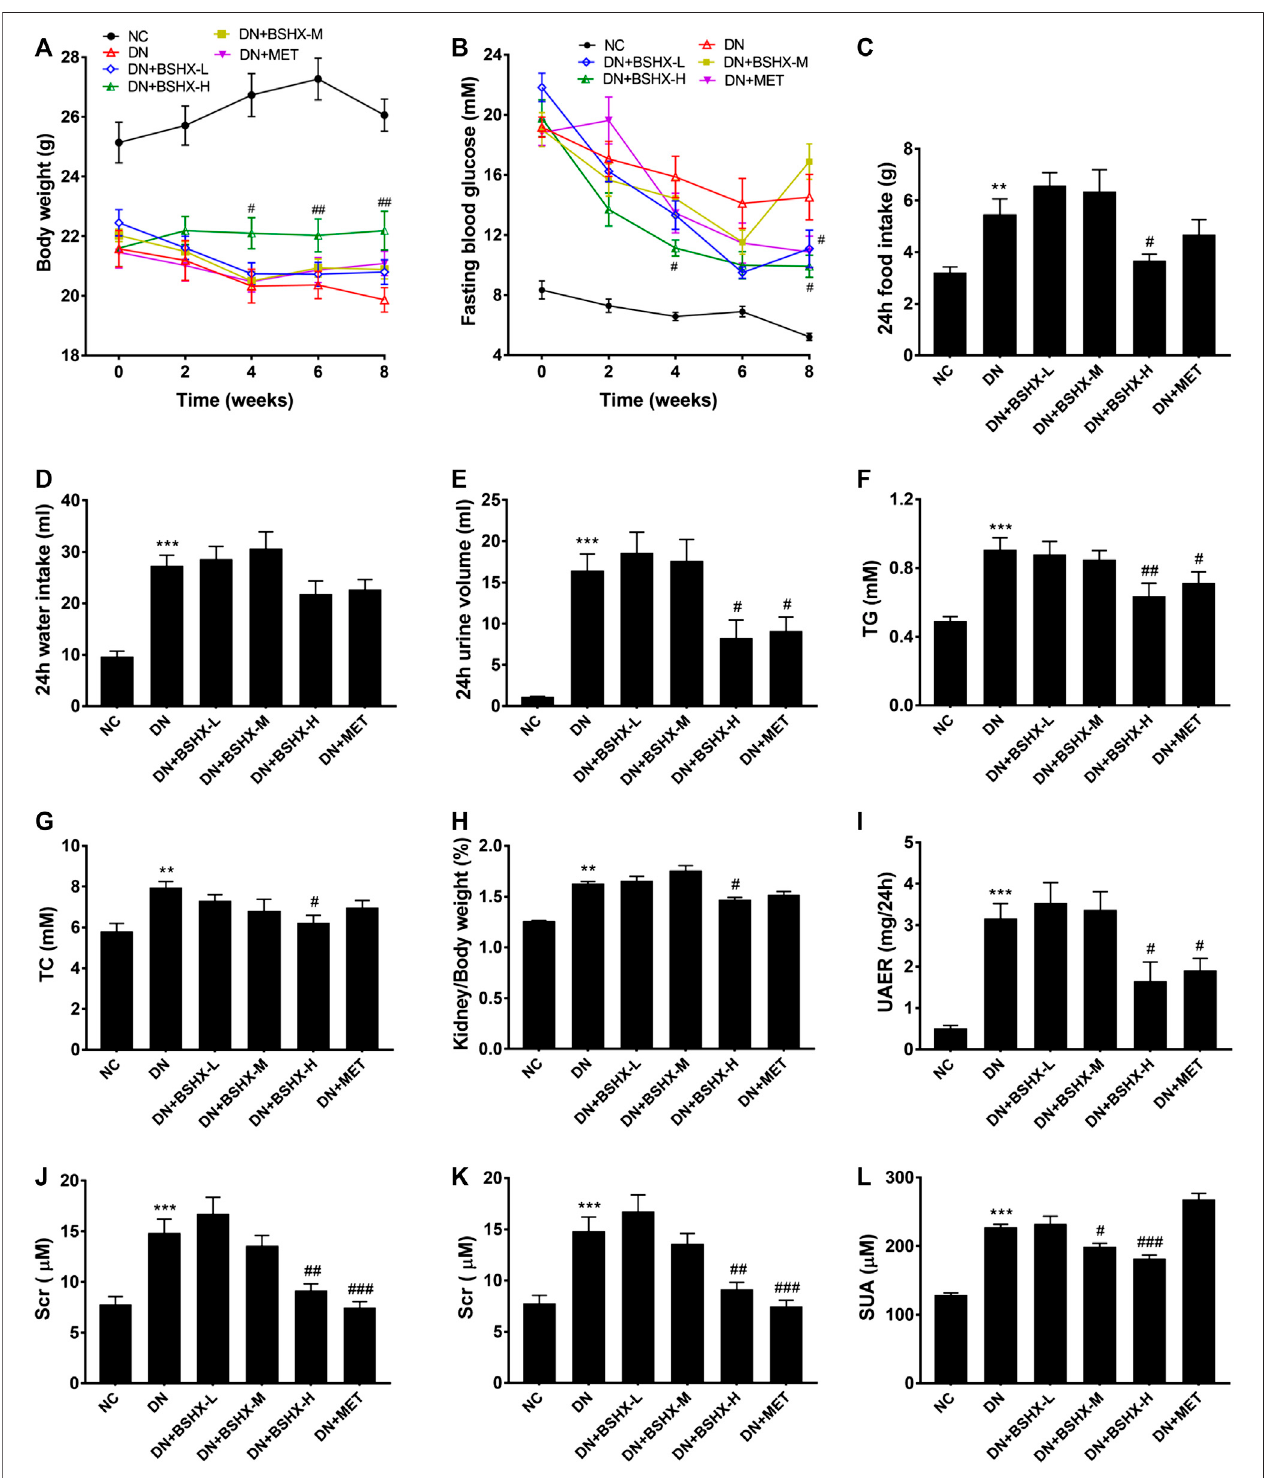
FIGURE 1 | BSHX decoction reduces diabetic metabolic parameters, urinary albumin excretion and ameliorates kidney function in DN mice. (A) Changes in body weight. (B) Changes in fasting blood glucose. (C) 24 h food intake. (D) 24 h water intake. (E) 24 h urine volume. (F) Serum triglyceride (TG). (G) Serum total cholesterol (TC). (H) Kidney weight/body weight. (I) Urinary albumin excretion rate (UAER). (J) Serum creatinine (SCr). (K) Blood urea nitrogen (BUN). (L) Serum uric acid (SUA). n (cid:1) 5 – 9 mice per group. All data are expressed as means ± SEM. * p < 0.05, ** p < 0.01, *** p < 0.001 vs. the NC group; # p < 0.05, ## p < 0.05, ### p < 0.001 vs. DN model